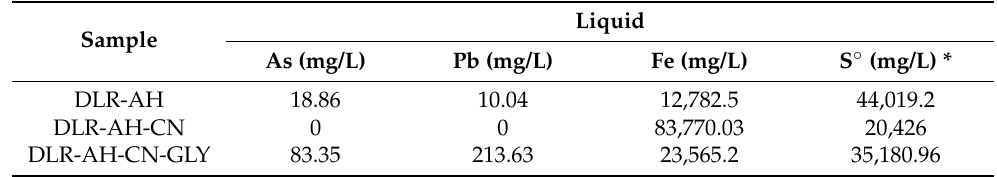
Table 5. Concentration of As, Pb, Fe, and S of the liquid samples obtained during the DLR-AH pretreatment and the conventional and glycine-assisted